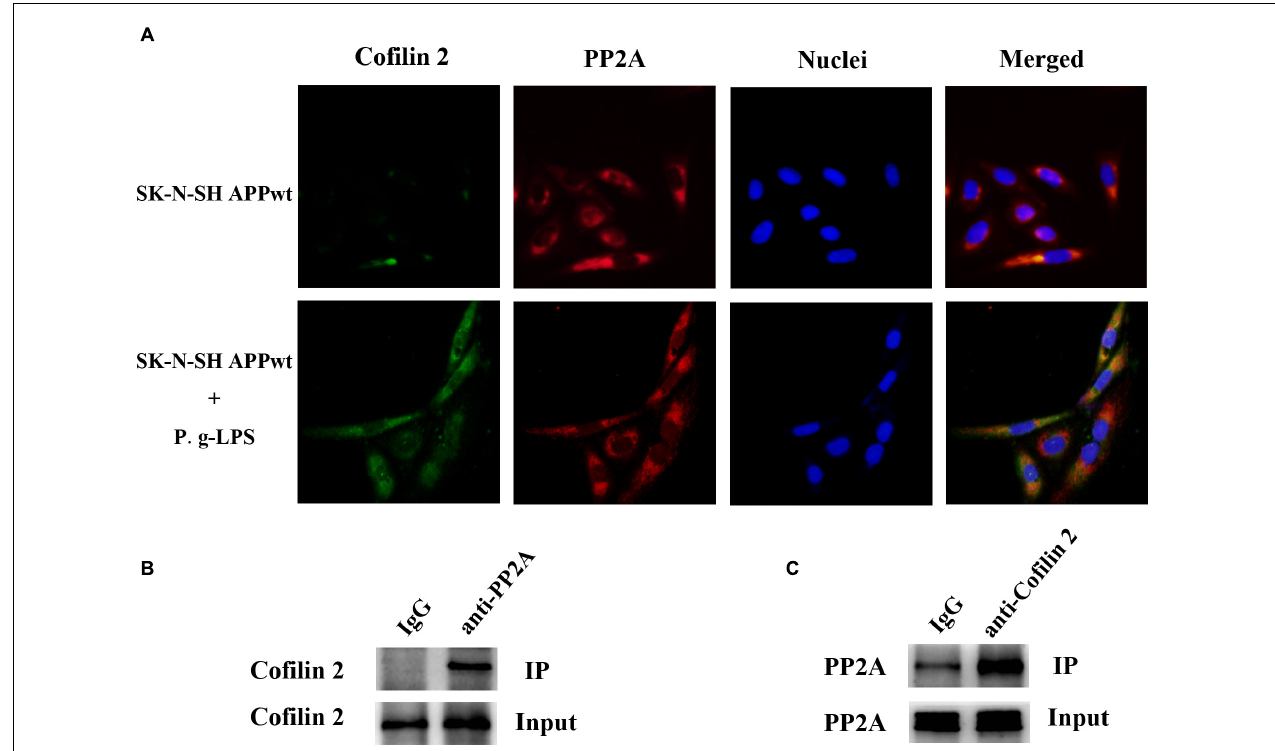
FIGURE 5 | Cofilin 2 co-localized and interacted with PP2A. (A) Interaction between Cofilin 2 and PP2A was determined by co-immunofluorescence staining (co-IF) in SK-N-SH APPwt cells and P.g-LPS treated SK-N-SH APPwt cells. (B) Representative panel of the Western blot of cofilin 2 in IgG group and anti-PP2A group after co-immunoprecipitation (co-IP) in P.g-LPS treated SK-N-SH APPwt cells. (C) Representative panel of the Western blot of PP2A in IgG group and anti-cofilin 2 group after co-immunoprecipitation (co-IP) in P.g-LPS treated SK-N-SH APPwt